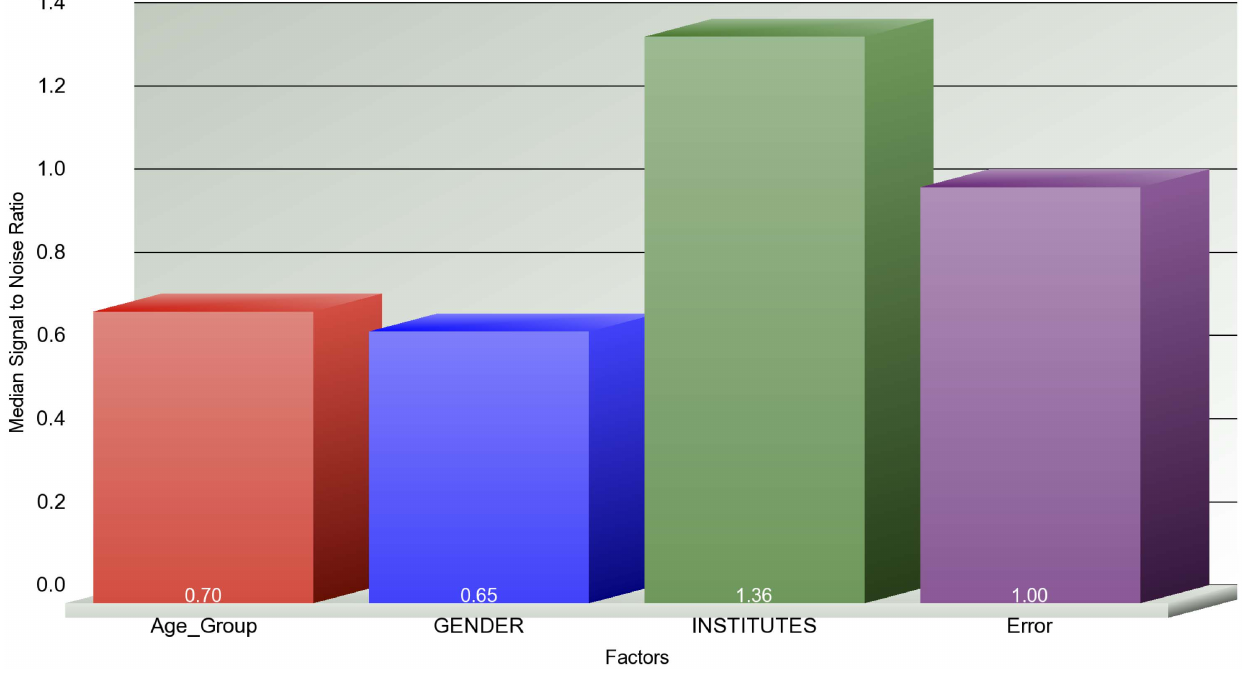
Figure 6. Source of variation of expression profiles of all genes in the REMBRANDT data set. The x-axis shows the components of the 3- way ANOVA model and the y-axis shows the median signal to noise ratio. The ANOVA model is built based on the expression profiles of all genes in REMBRANDT data set.